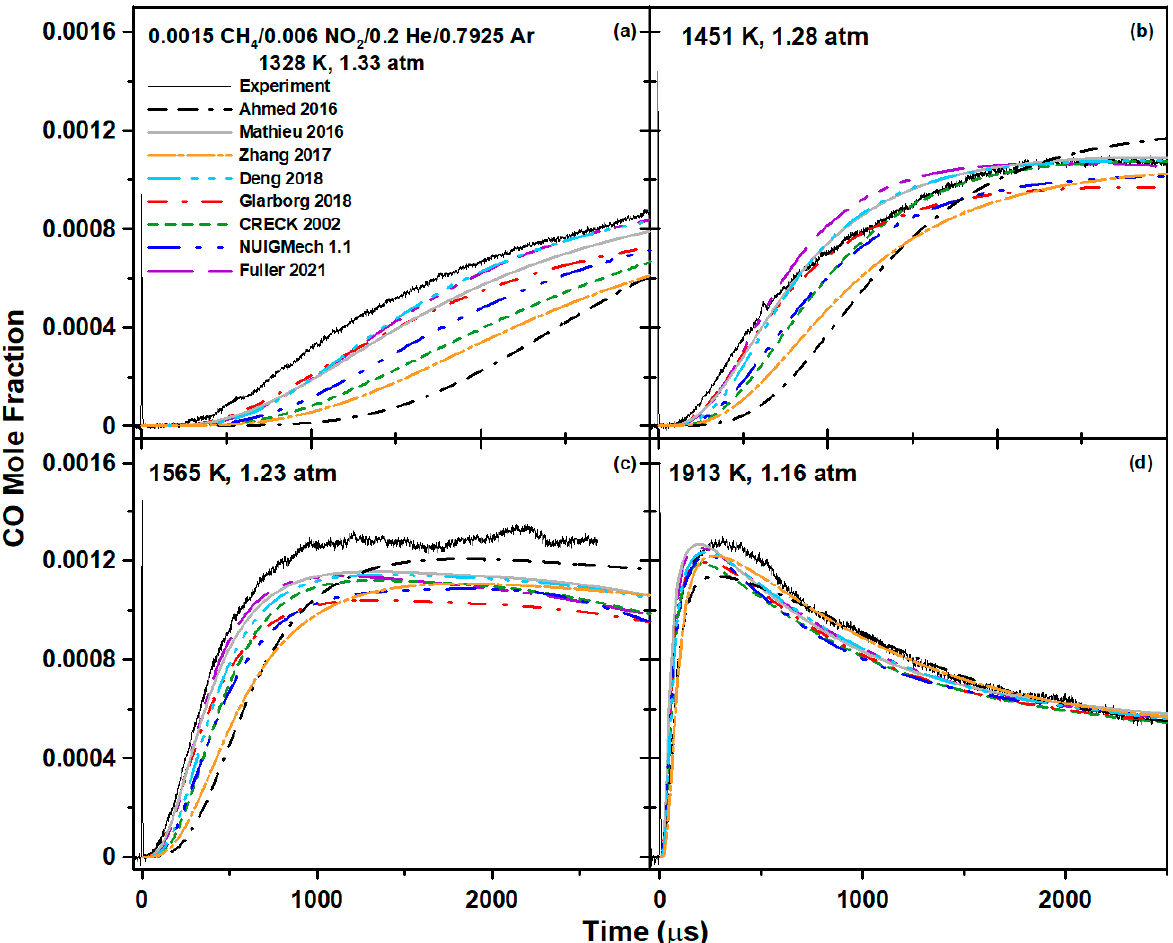
Figure 6. Comparison between experimental CO profiles and predictions of detailed kinetics models from the literature for a 0.0015 CH 4 /0.006 NO 2 /0.2 He/0.7925 Ar mixture at around 1.2 atm and for various temperatures: ( a ) 1328 K, ( b ) 1451 K, ( c ) 1565 K, and ( d ) 1913 K.